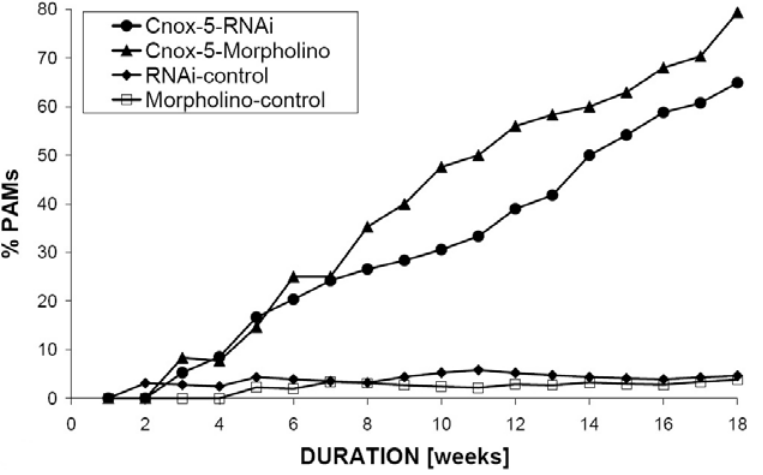
Figure 2. Time course for the development of phenotypic effects resulting from Cnox-5 gene knock down. Both morpholino oligo and RNAi experiments result in an increase of p henotypically a bnormal m edusae (PAMs) over time. Shown is the time course of increasing numbers of PAMs as a result of inhibition by double stranded RNA and inhibition by morpholino-antisense oligonucleotides. In each case control 1 is untreated animals cultured in normal seawater, and control 2 is a sense morpholino oligonucleotide or dsRNA targeted to the Trox -2 gene from the placozoan Trichoplax adhaerens respectively. Independent controls were run for each single experiment. doi:10.1371/journal.pone.0000694.g002 PLoS ONE |